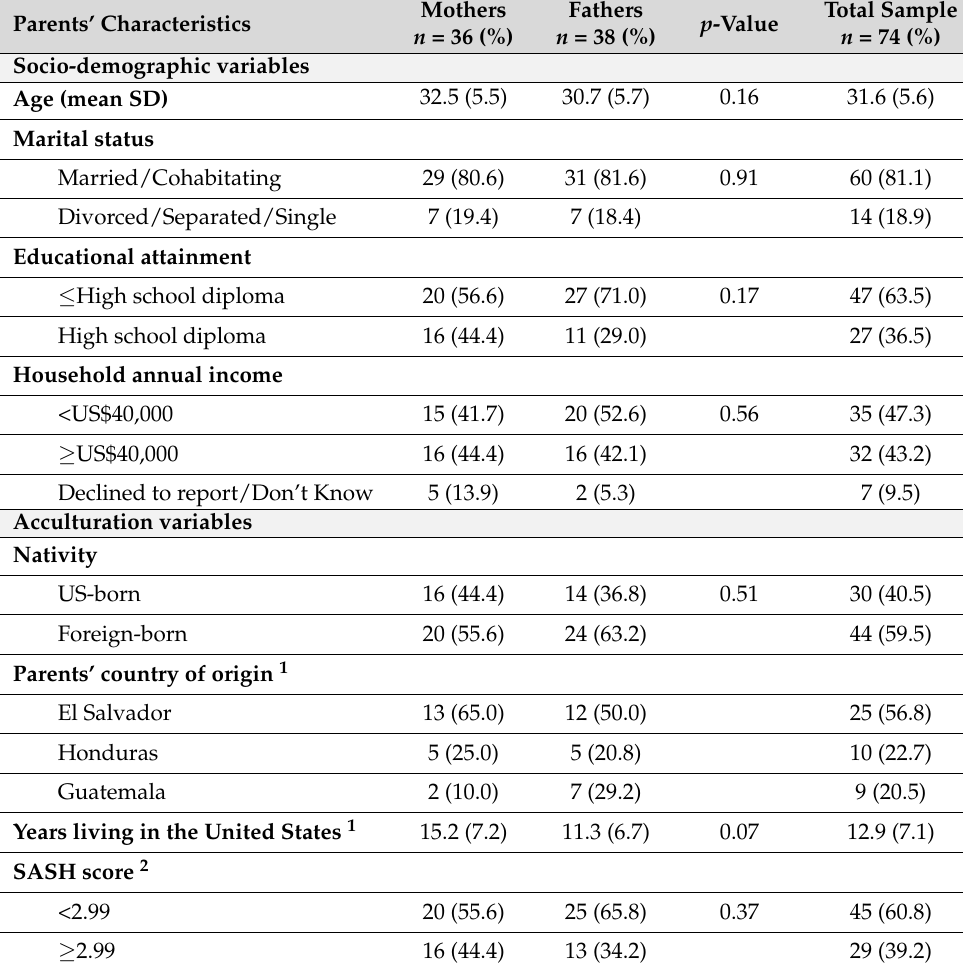
Table 1. Socio-demographic and acculturation characteristics of study participants ( n =